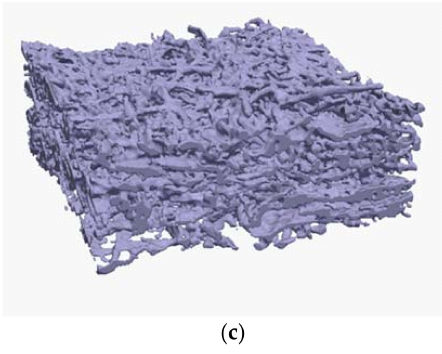
Figure 1. Scanning electron microscopy (SEM) and X-ray CT scan images of Si/G/CP with 16 wt % and 5 µ m Si; ( a ) surface; ( b ) cross section; and ( c ) X-ray CT scan image.